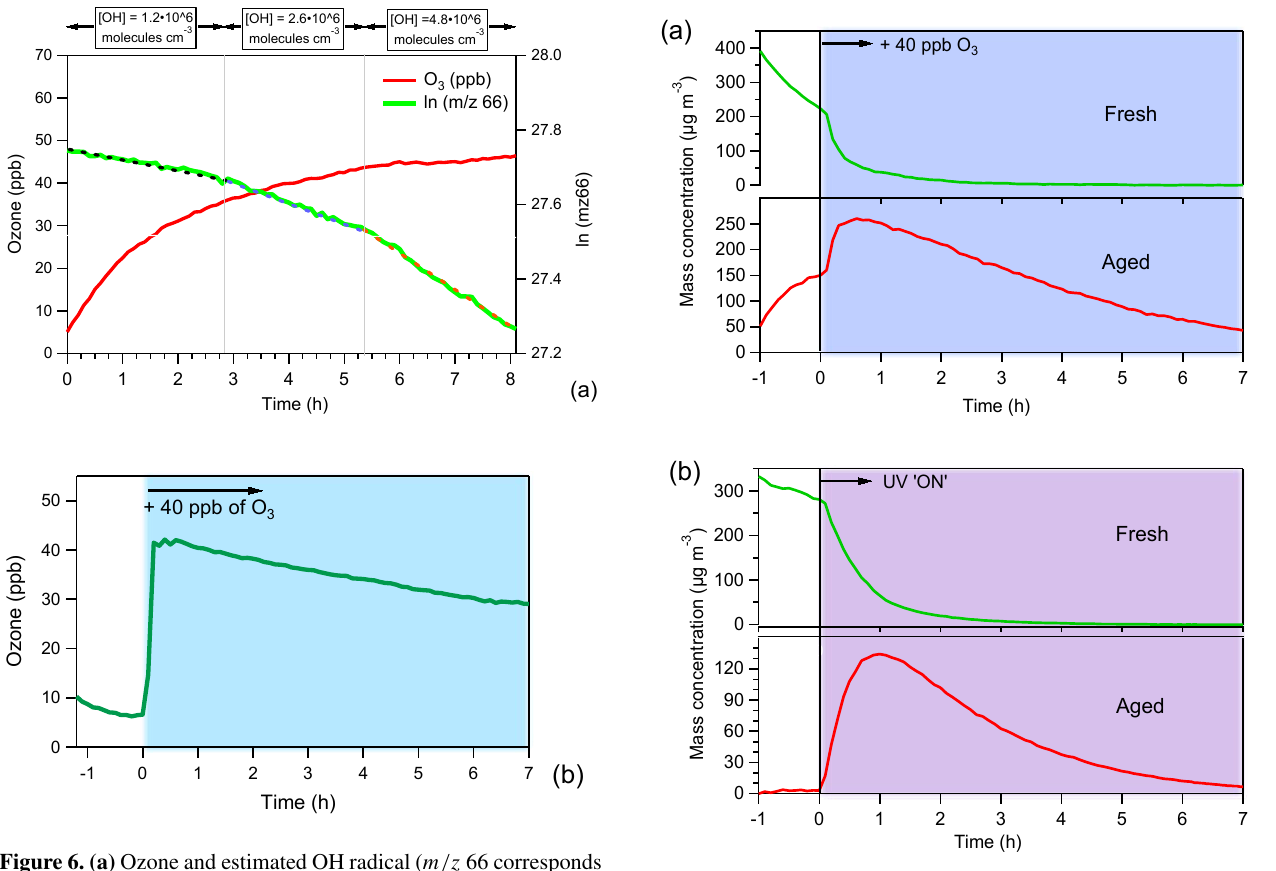
Figure 8. Time series of the resulting factors from the PMF analysis of the chamber experiments without corrections for losses to walls. (a) PMF factors for Experiment 3 (O 3 addition) and (b) PMF factors for Experiment 4 (UV illumination).